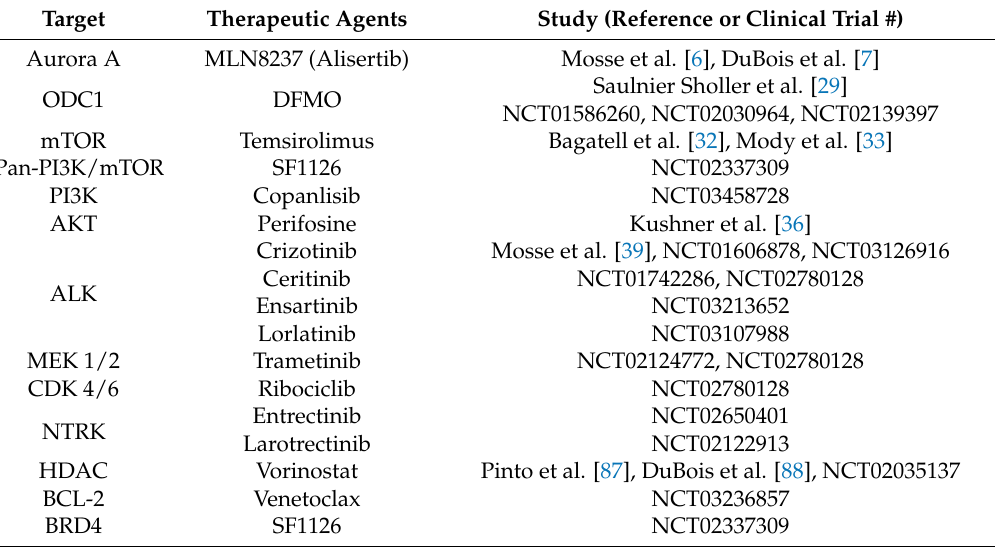
Table A1. Molecularly targeted agents in clinical development for the treatment of neuroblastoma. Target Therapeutic Agents Study (Reference or Clinical Trial #) Aurora A MLN8237 (Alisertib) Mosse et al. [6], DuBois et al. [7] Saulnier Sholler et al.